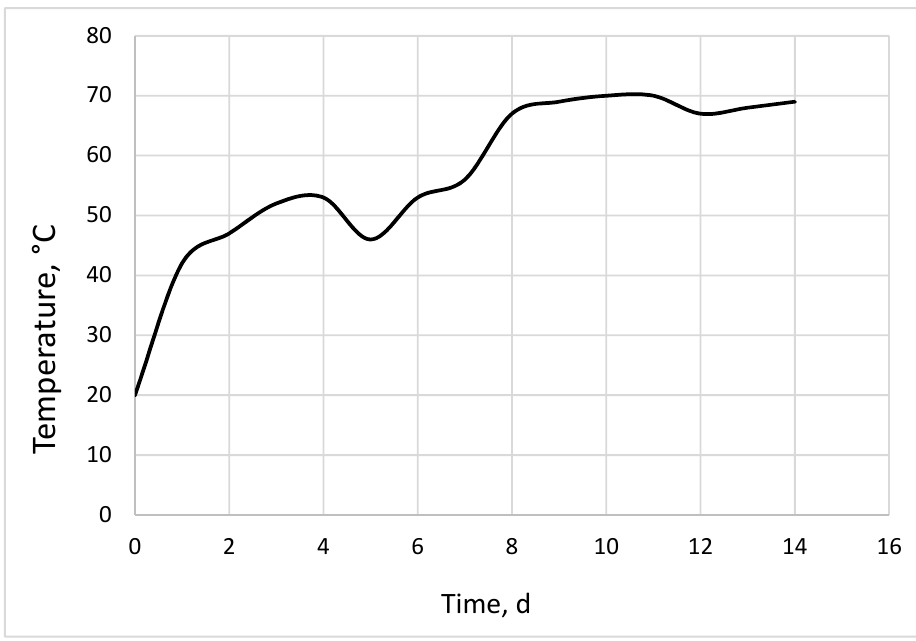
Figure 2. The typical temperature pattern during composting was used for CO accumulation modeling [32,33].